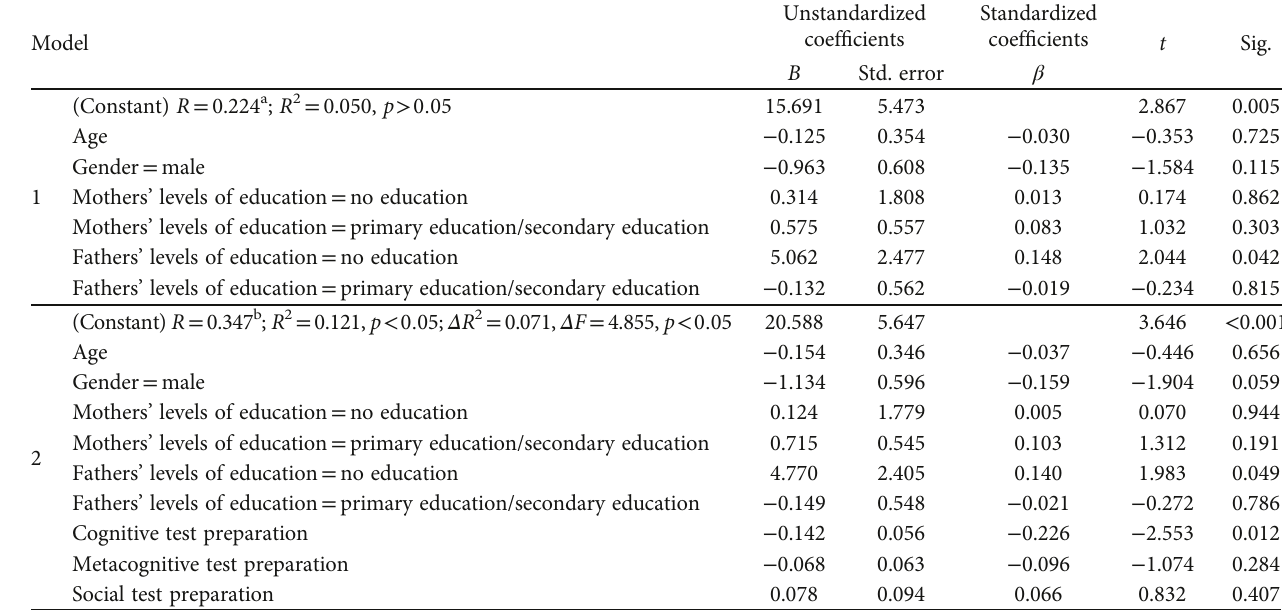
T ABLE 2: Hierarchical regression analysis for test preparation strategies and worry test